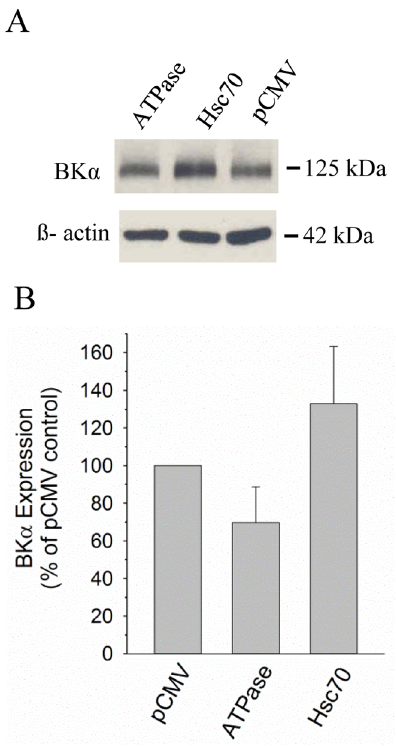
Figure 5. Hsc70 does not reduce BK channel expression in the absence of CSP a . A. CAD cells were transiently co-transfected with 1 m g cDNA encoding BK a subunit and either 1 m g HA-tagged, wild-type Hsc70 or the Hsc70 ATPase domain. Empty pCMV vector (1 m g) was co- transfected with 1 m g cDNA encoding BK a subunit as a transfection control. 24 h post-transfection, the cells were lysed and BK channel and b -actin expression was analyzed. B . The histogram quantifies the relative changes in cellular BK channel expression in the presence of WT Hsc70 and the Hsc70 ATPase domain, which were not statistically different than the control (i.e. pCMV vector